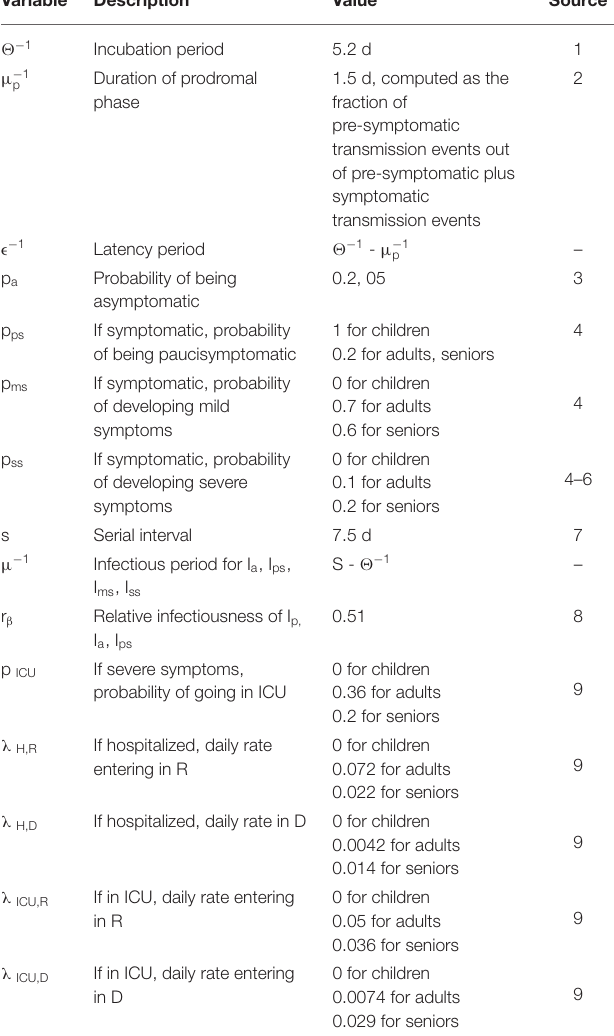
TABLE 4 | Matrix contact (value of Contact Popi*Popi ′ ,Init ) for the different populations.